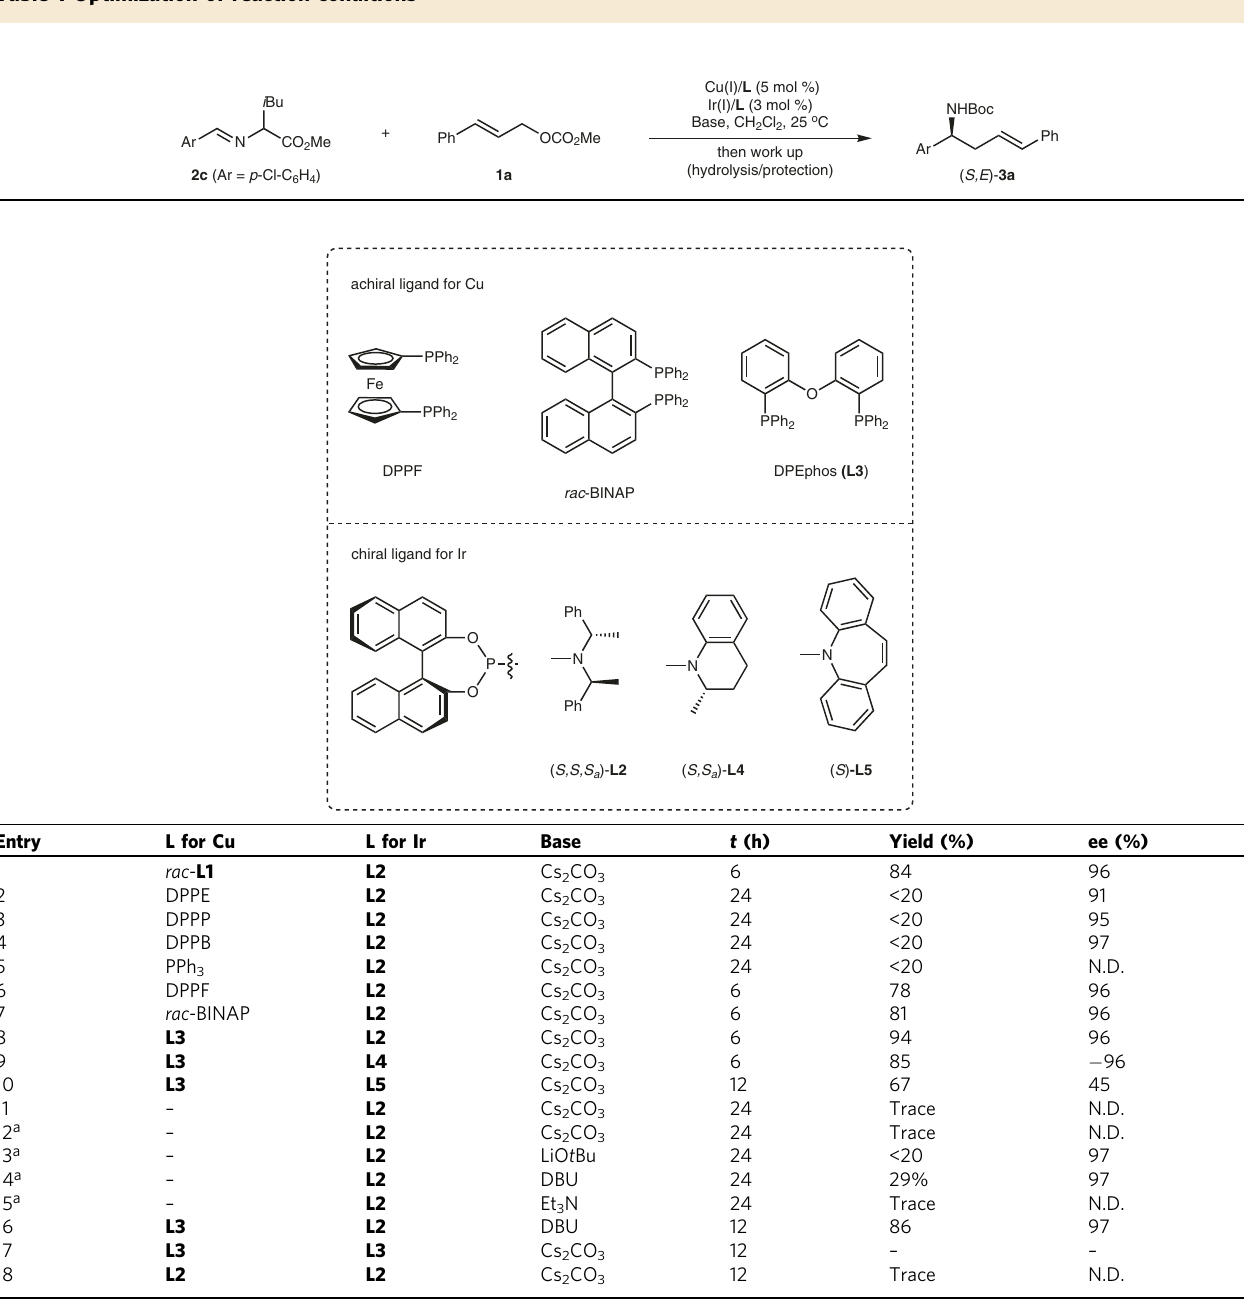
Table 1 Optimization of reaction